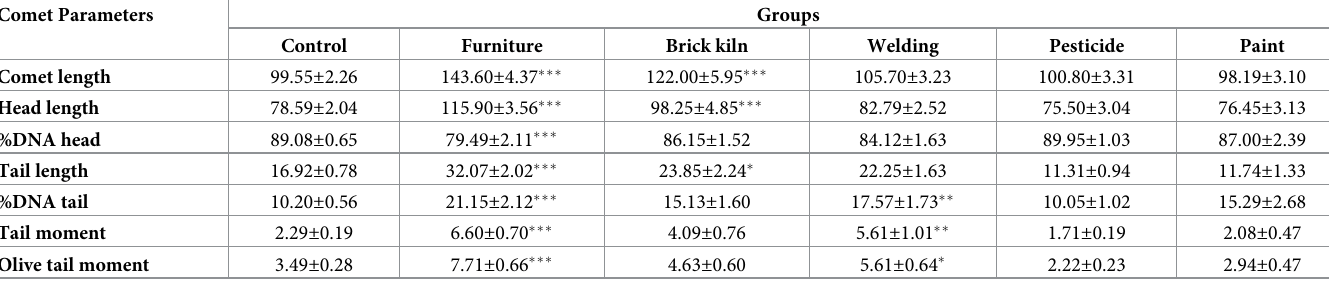
Table 2. Comparison of different comet parameters between control and different industries. Comet